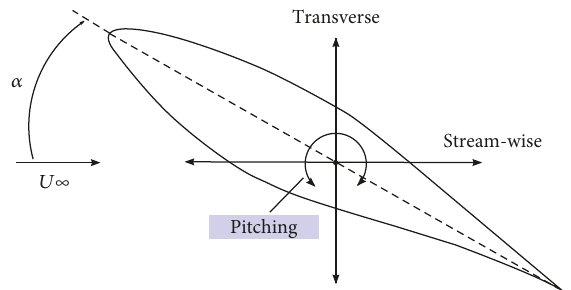
Figure 1: Schematic of a 2D airfoil degrees of freedom at a positive incidence with respect to the fl ow direction. The airfoil is the NREL S809. The highlighted motion is the only considered in this